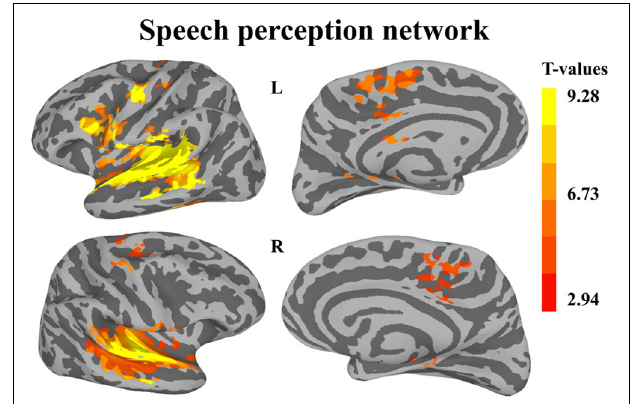
FIGURE 2 | Whole-brain analysis of BOLD response illustrating regions significantly active during speech perception. Activation is shown on the group average smoothed flattened surfaces. All analyses are controlled for multiple comparisons using a cluster extent of 157 vertices, and a single node threshold of p < 0 . 01, to achieve a family-wise error rate of p < 0 . 001.